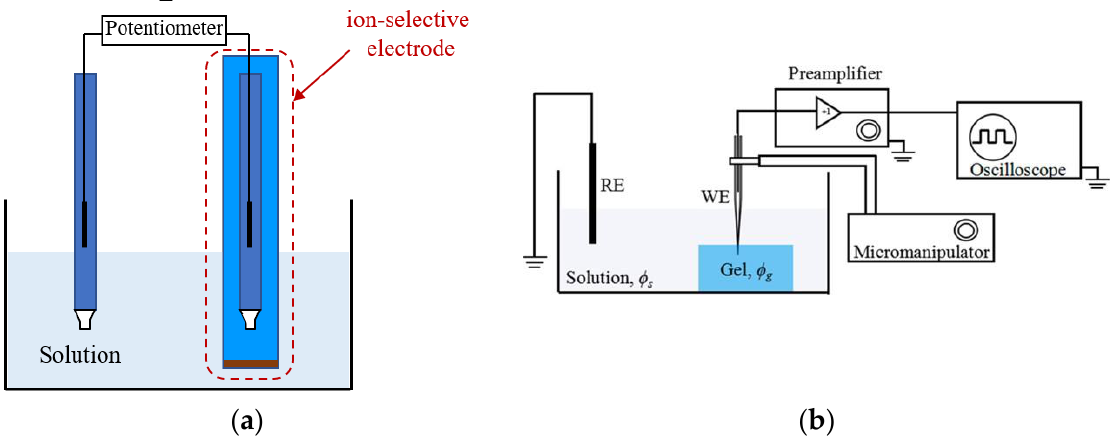
Figure 1. ( a ) Simplest setup for EMF (electromotive force) measurement; ( b ) setup for MET (micro-electrode technique) measurement. Reproduced with permission [22] . Copyright 2016, American Chemical Society.